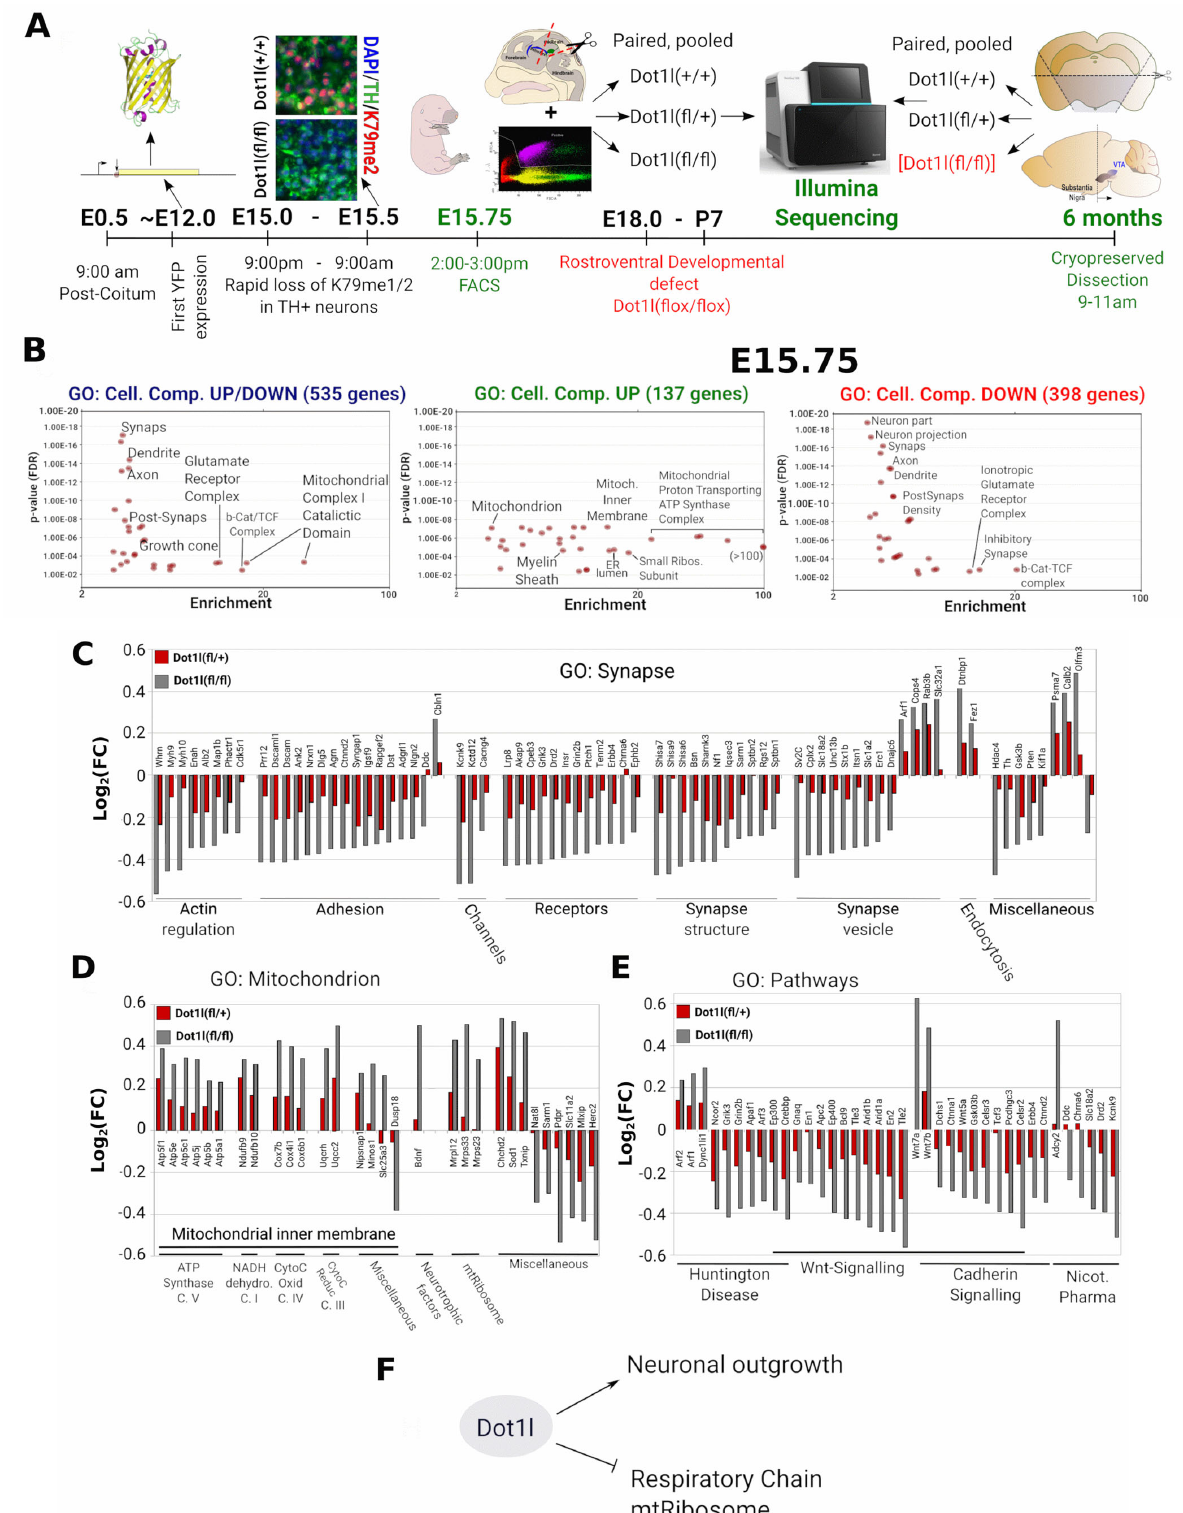
represented by the level of H3K79 methylation. Taken together, in maturing DA neurons, genes involved in neuronal function outgrowth are generally activated by Dot1l and/or H3K79 methylation, next to Wnt signaling (Figure 4E). Importantly, many genes belong ‐ ing to the family of the respiratory chain are repressed (Figure 4F). This suggests that Dot1l activity (H3K79 methylation) is repressive for the electron transport function and beneficial towards other neuronal functions. (Figure 4F).